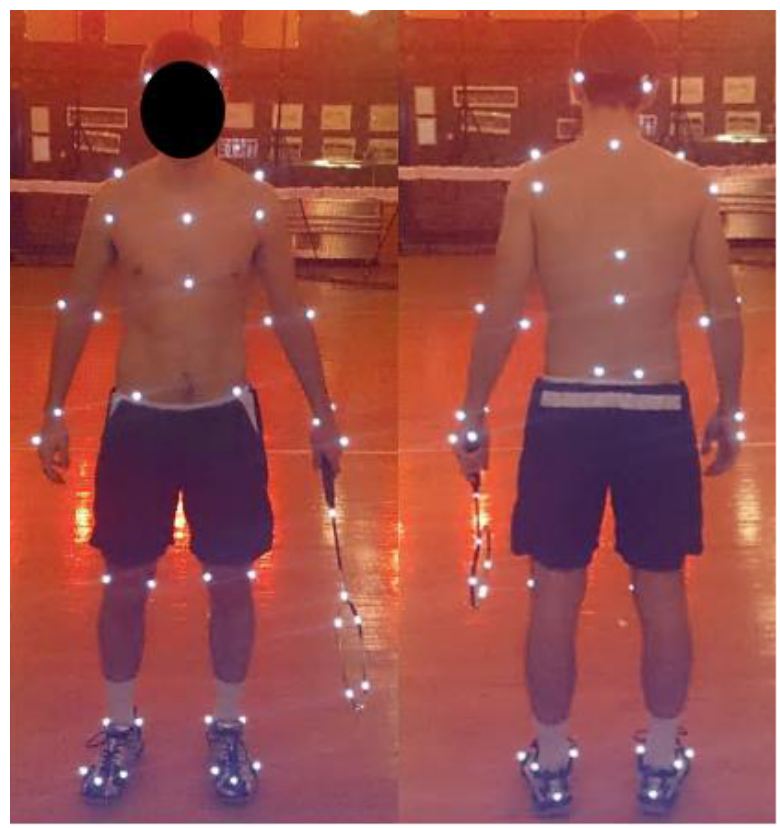
Figure 1. Participant marker locations.